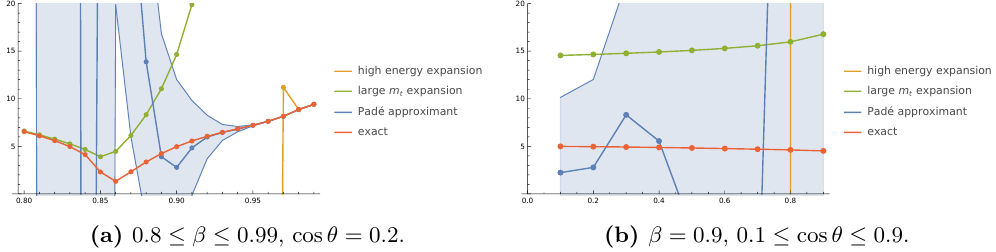
Figure 5. Comparison of the interference for the LRLL helicity